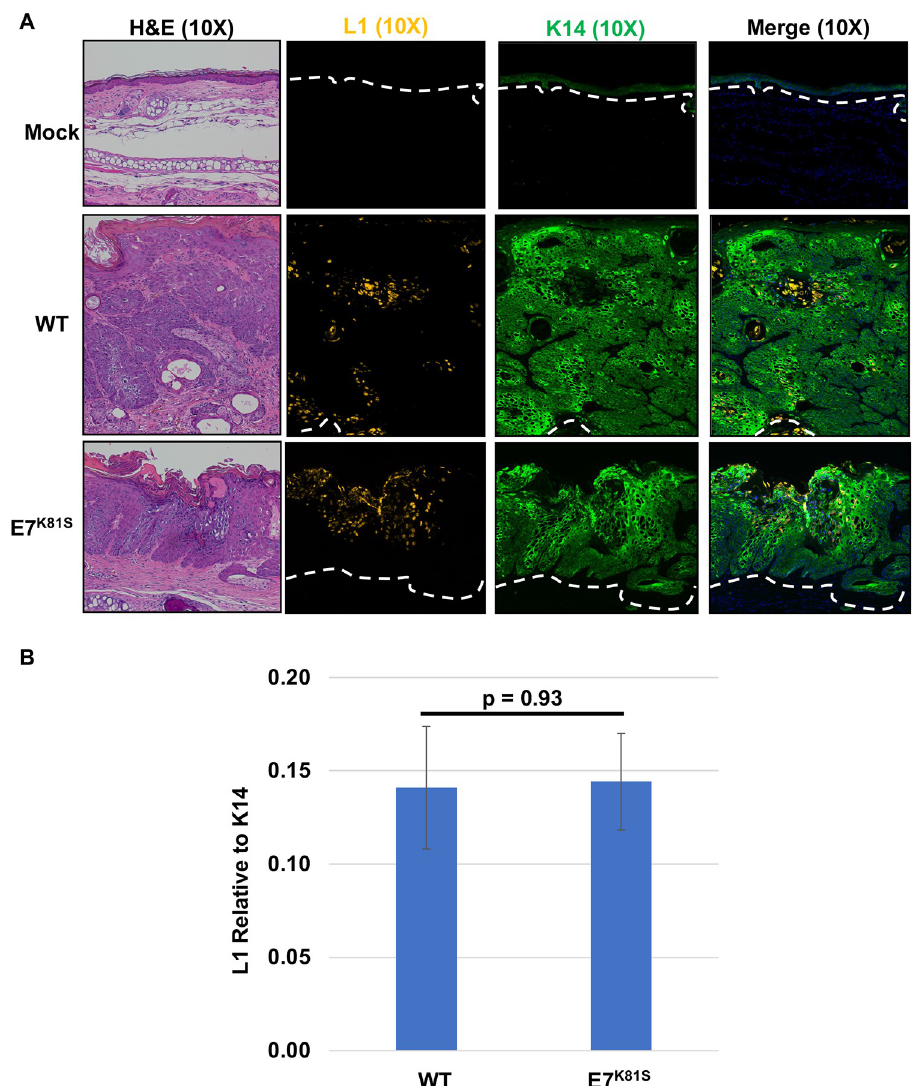
Fig 6. MmuPV1 E7 K81S mutant does not impair capsid protein production. (A) FFPE tissue sections were subjected to immunofluorescence (IF) analysis using a tyramide signal amplification (TSA) system using antibodies against K14 (green) and the viral capsid protein L1 (yellow). Representative images are shown for K14, L1, and merged (which includes Hoechst stain) at 10X magnification. A 10X image of the H&E is also shown. Dashed white lines indicate basement membrane of epithelial tissues. (B) IF images were quantified using ImageJ to determine area of lesion that stained positive for L1 and K14 using 9 images per condition. L1 signal was normalized to K14 signal. Standard error is shown. Wilcoxon Rank Sum test was performed to assess statistical significance and p-value is